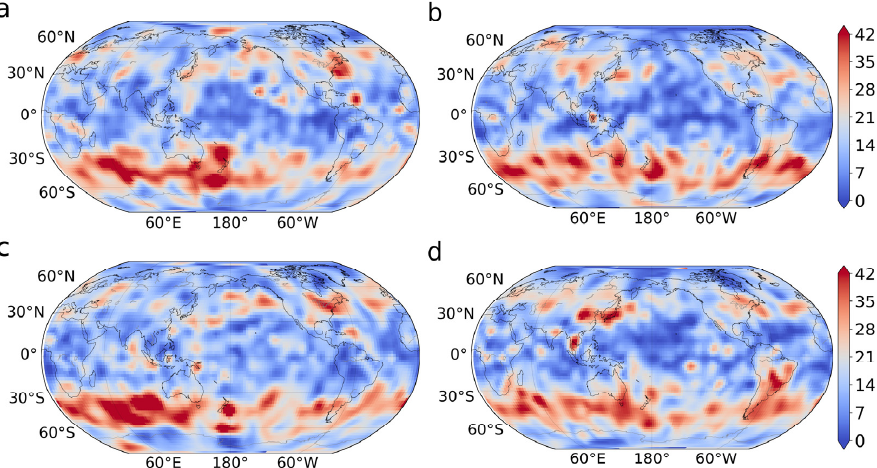
Figure 2. Maps of in-degree distribution for ( a ) 1949 and ( b ) 2020. Maps of out-degree distribution for ( c ) 1949 and ( d ) 2020. The color bar stands for the nodes’ degree.